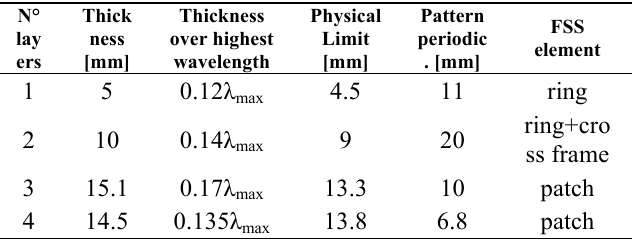
Table 2: Electrical and geometrical parameters of the analyzed wideband and ultra-wideband absorbing structures. The physical limit is computed according to [28].